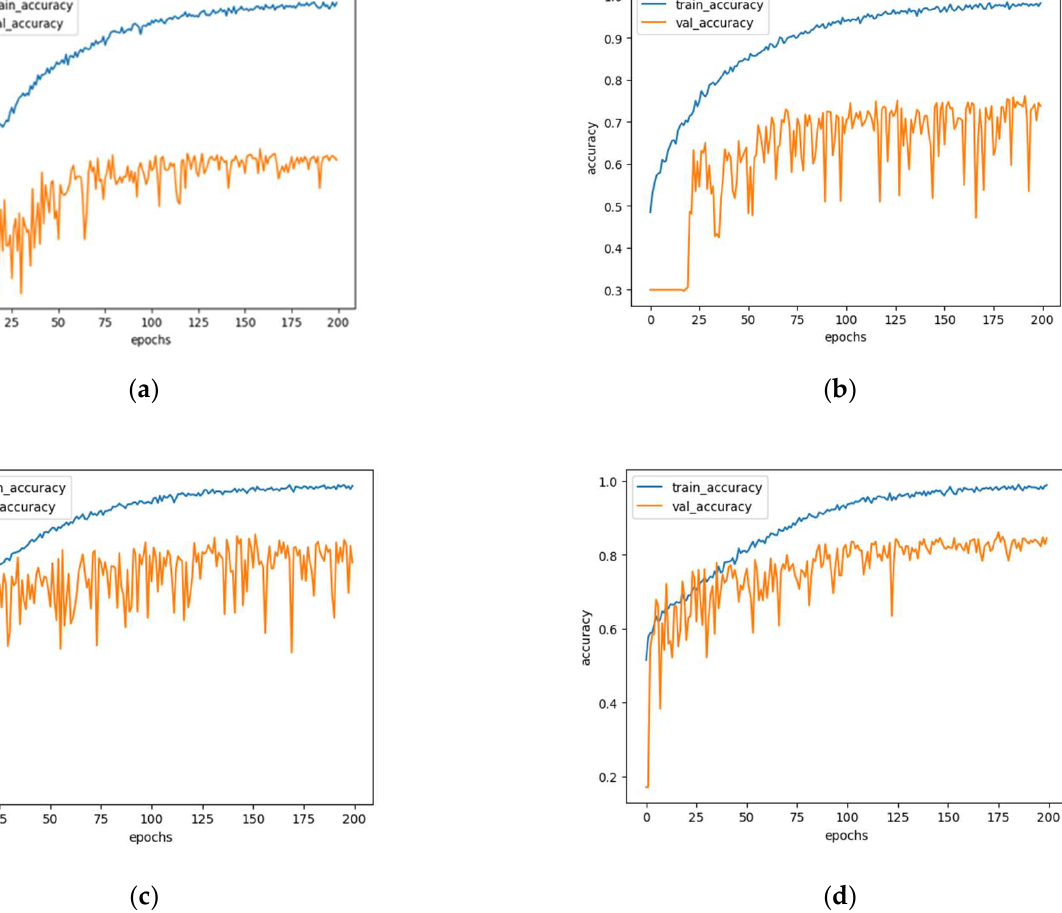
Figure 6. Accuracy of MobileNet ( a ) and HDM-NET ( b ) and the choice of attributes used for MobileNet ( c ) and HDM-NET ( d ).